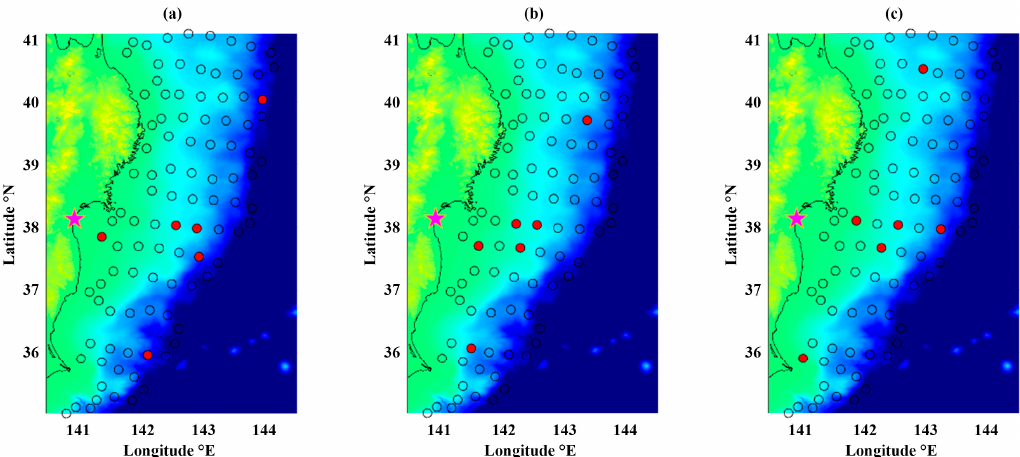
Figure 14. Spatial maps of sensors for the risk-based early warning in Iwanuma: ( a ) 5 min, ( b ) 10 min, and ( c ) 20 min. The pink star represents the target location (Iwanuma). The red and empty circles represent the selected and unselected sensors, respectively.